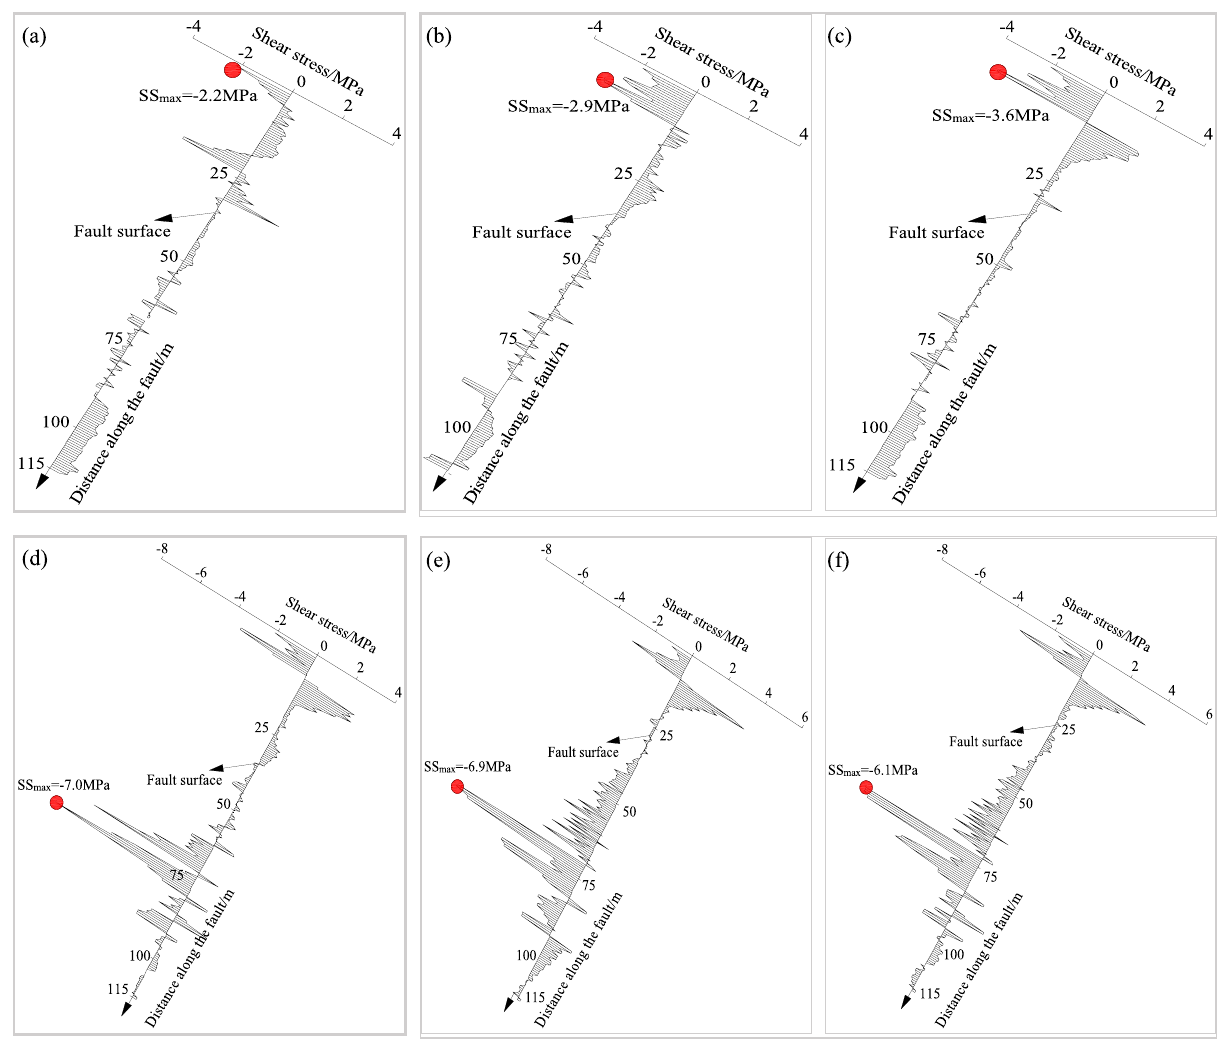
Figure 17. Evolutionary process of the shear stress along the fault plane under different roadway formation